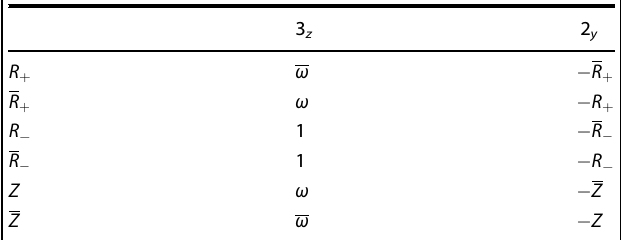
Table 1. Transformation properties of R ± , Z, and their complex conjugates (see Eq. (11)) under the generators of P321 group, 3 z , and 2 y (here, ω ¼ e i 2 π 3 and ω ¼ e (cid:2) i 2 π 3